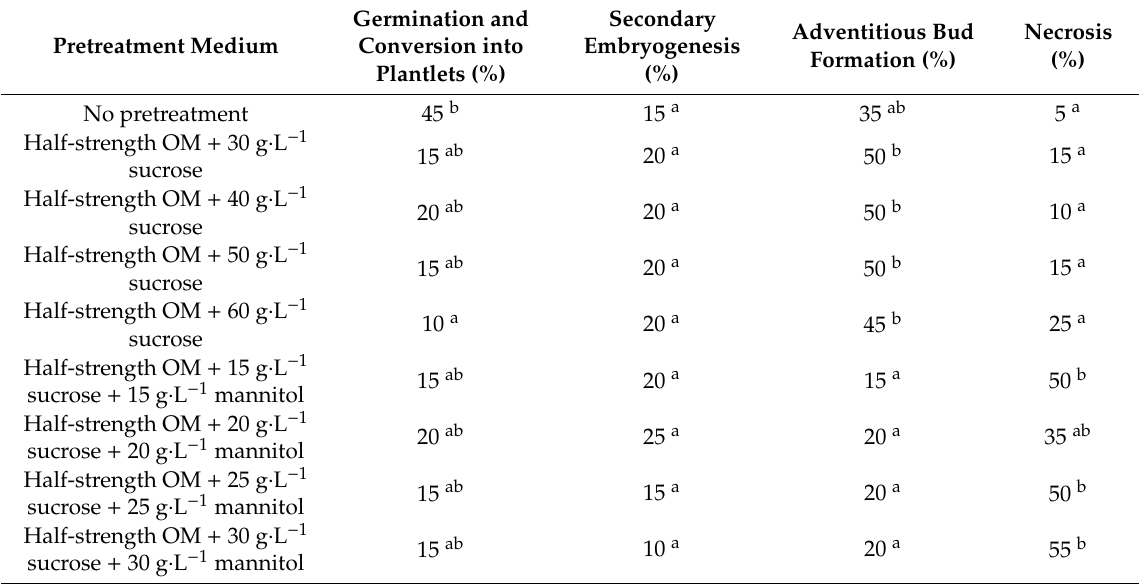
Table 4. E ff ect of di ff erent pretreatments on somatic embryo germination and conversion into plantlets. Pretreatment Medium